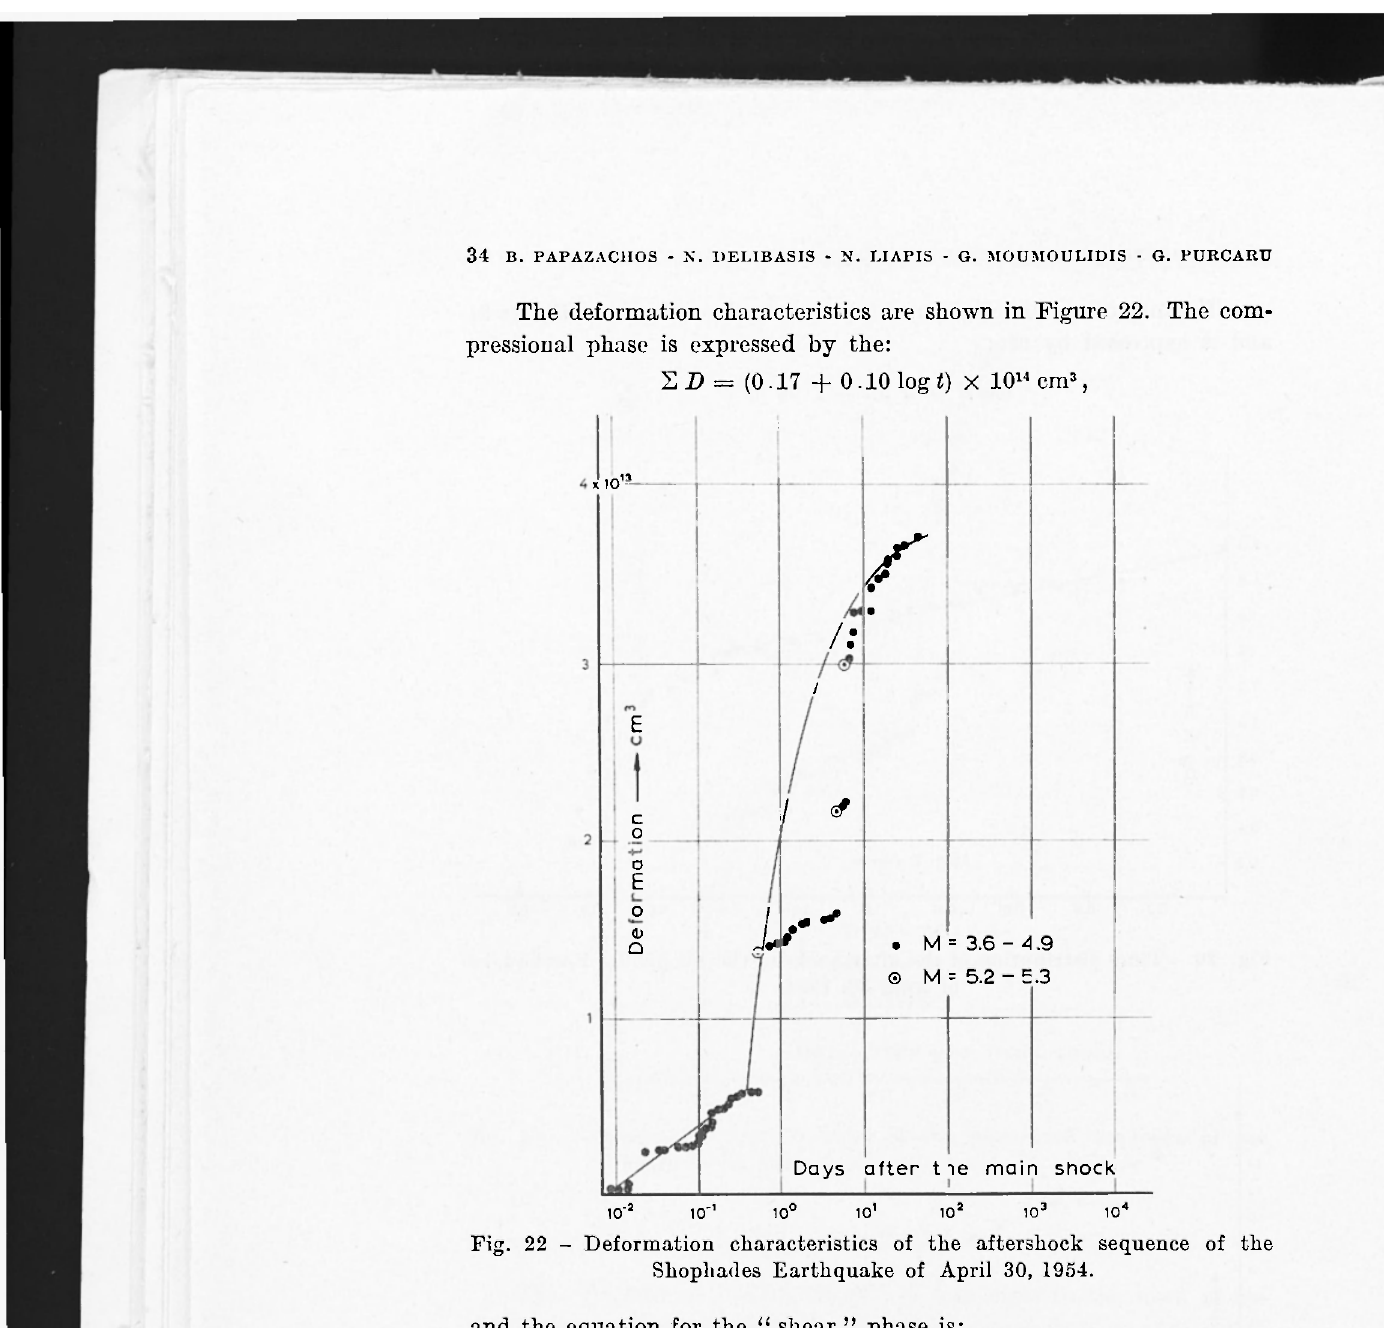
Fig. 22 - Deformation characteristics of the aftershock sequence of the Shopliades Earthquake of April 30,